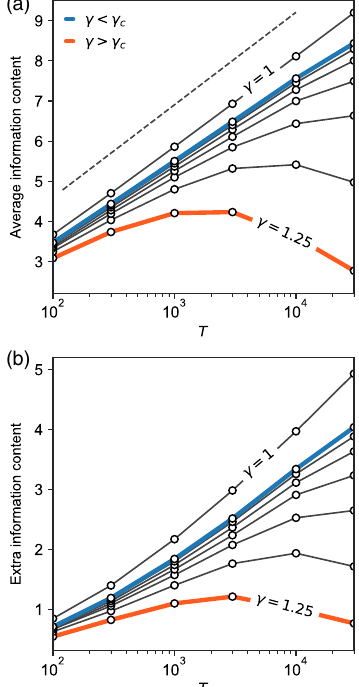
FIG. 5. Finite-size scaling of the average information content. (a) Average information content h S ð G Þi of tree networks ( b ¼ 1 ), as a function of network size T , for exponents γ ∈ f 5 of the nonlinear kernel. Color matches what is highlighted in Fig. 4(a). We know that these are upper and lower bounds on γ c due to the scaling analysis. The dotted line is the upper bound log ð T Þ on the information content. (b) Information content not accounted for by the degree classes, i.e., h S ð G Þ − S G Þ is the Shannon entropy of the partition obtained where S deg ð by classifying edges according to their nodes ’ degree (see text).